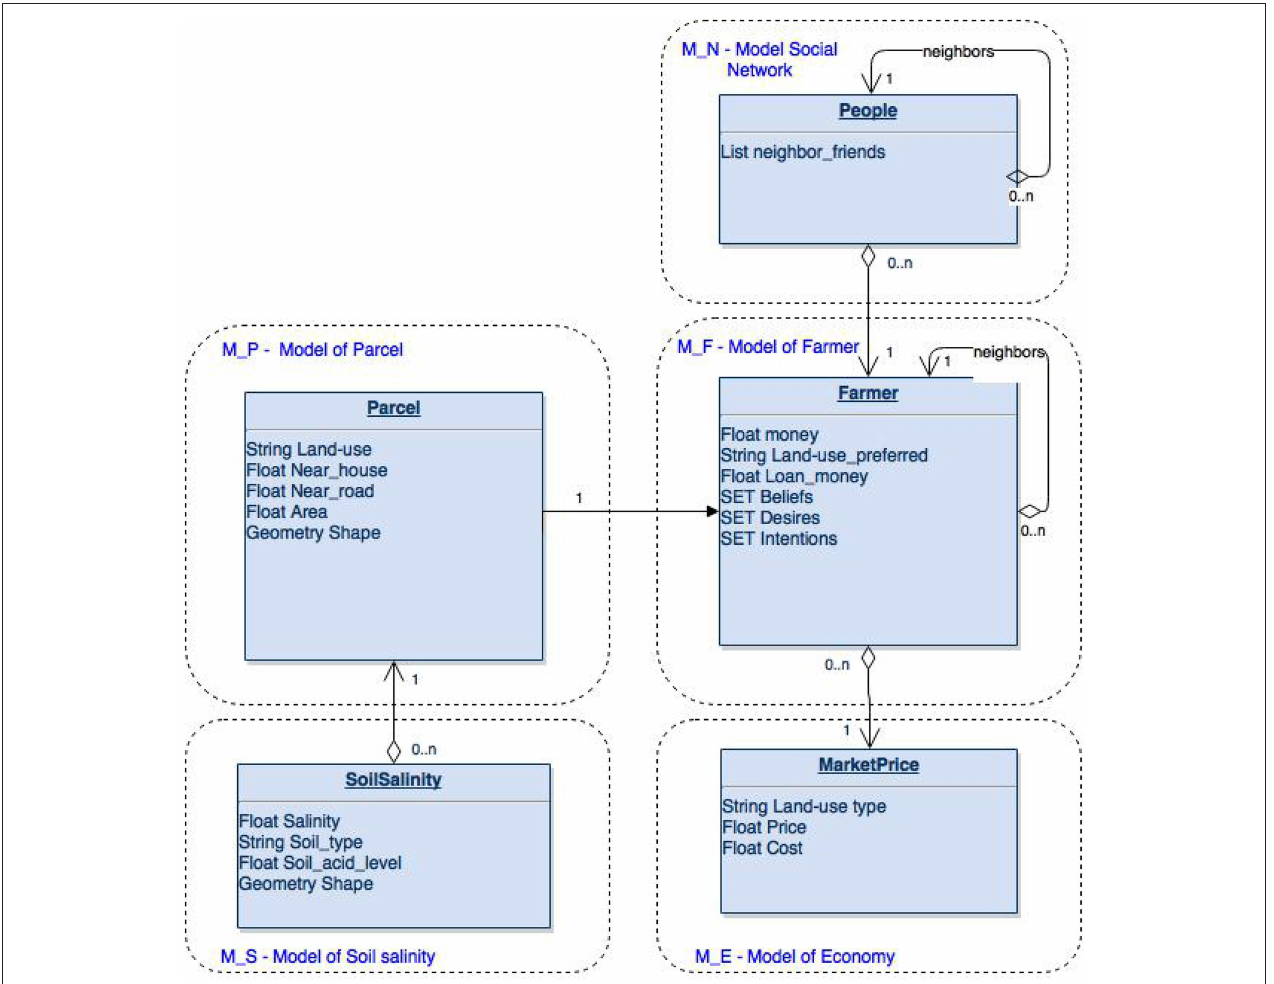
FIGURE 6 | Conceptual view of the five sub-models that constitute our integrated